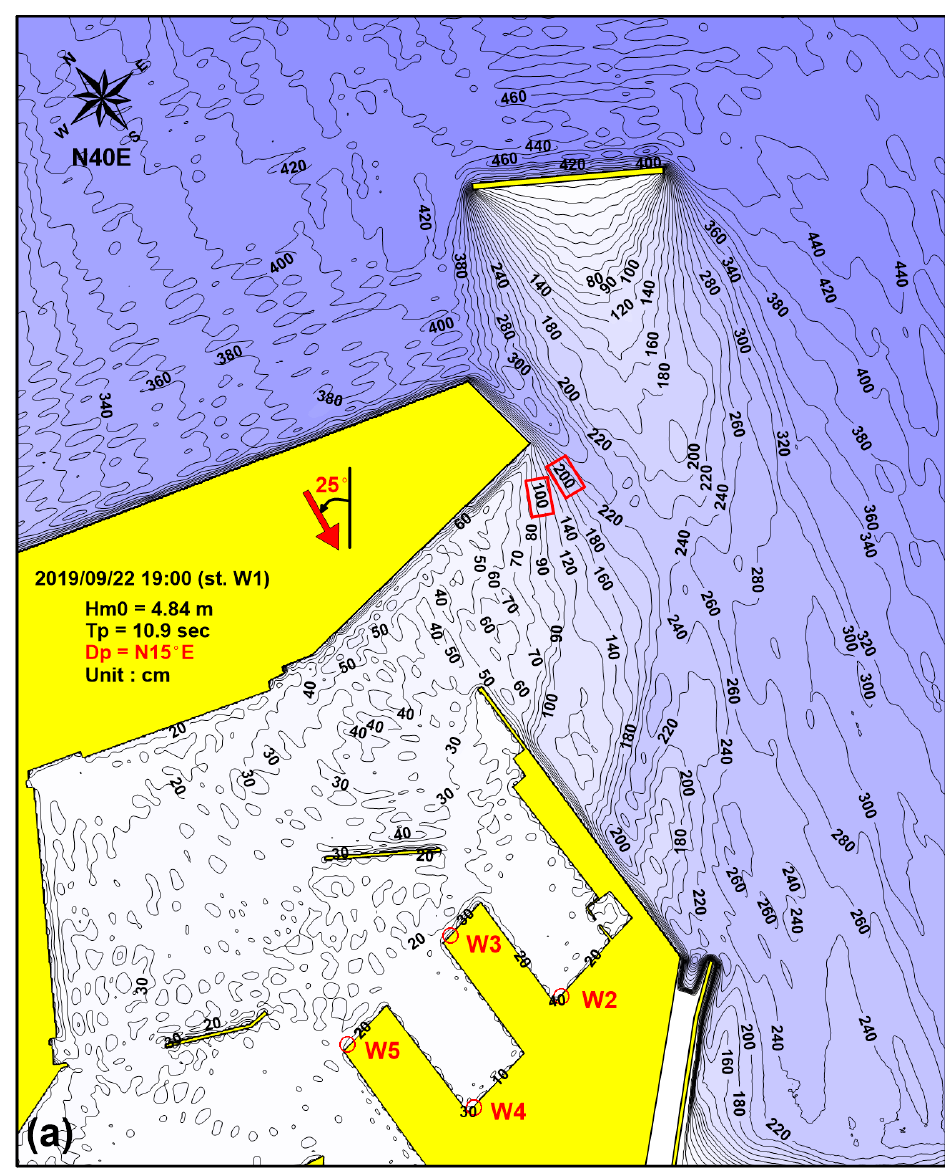
ple, the 𝐻 (cid:3040)(cid:2868) value was reduced from ~2.0 m to ~1.4 m (marked in the red rectangles in Figure 19b) for the similar distance marked in Figure 19a. As a result, the 𝐻 (cid:3040)(cid:2868) value be- came higher inside the port, compared to that of 𝐷 (cid:3043) with N15.0 ° E, with the 𝐻 (cid:3040)(cid:2868) range of 0.4–1.2 m inside the port, providing 𝑅 (cid:3024)((cid:3040)(cid:3042)(cid:3031)(cid:3032)(cid:3039)) of 8–25% (Figure 19b). The impact of wave direction in the case of AC is further discussed in Section